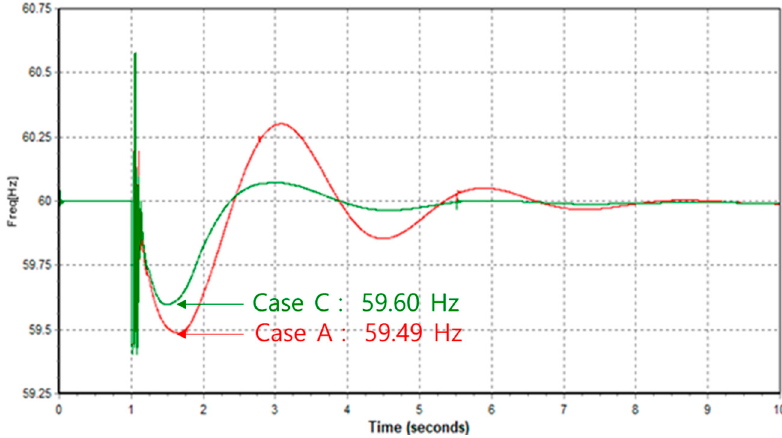
Figure 6. Simulation results of Cases A and C; effect of BESS operation.